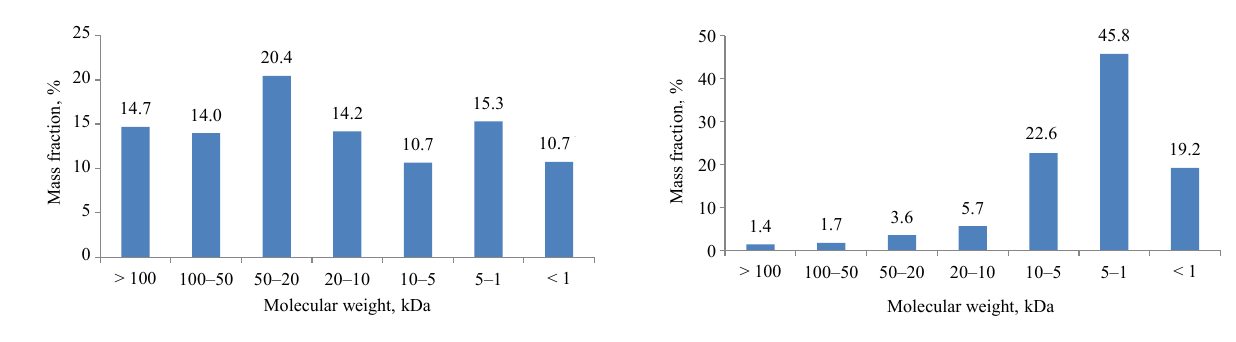
Figure 2 Protein distribution based on molecular weight of peptides and their share in protein hydrolysates from sockeye heads after thermo-enzymatic hydrolysis